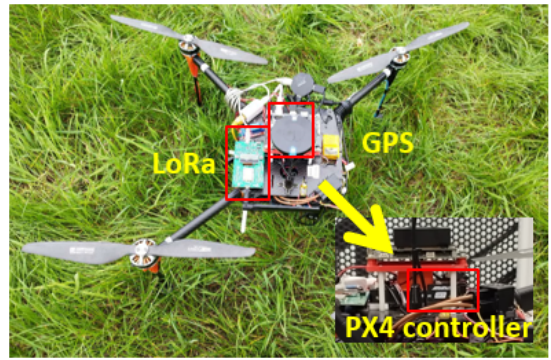
Figure 2. The UAV and its hardware layout.